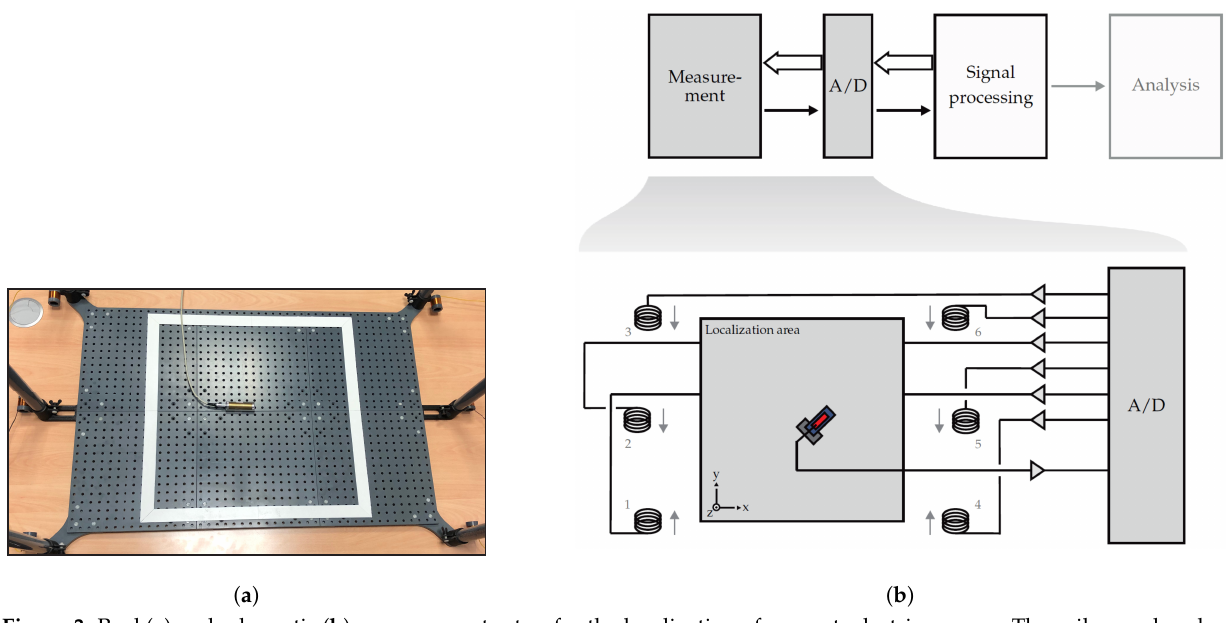
Figure 3. Real ( a ) and schematic ( b ) measurement setup for the localization of magnetoelectric sensors. The coils are placed outside of the localization area and transmit orthogonal signals, which are measured by the sensor. The localization area (box bounded by white stripes in ( a )) is of size 50 cm × 50 cm.